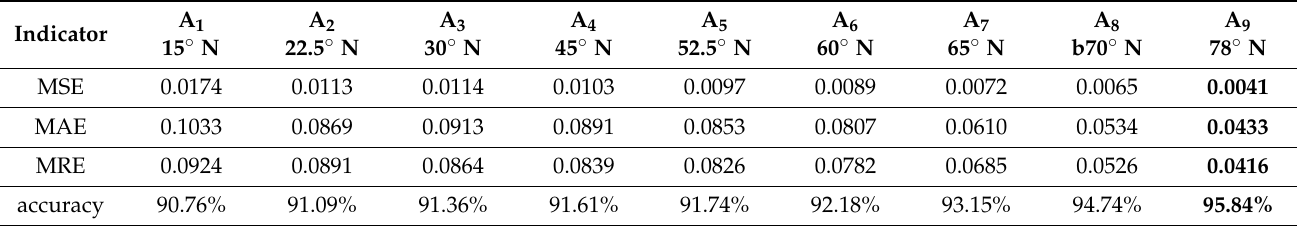
Table 9. Prediction effect of the proposed model in LSA periods.